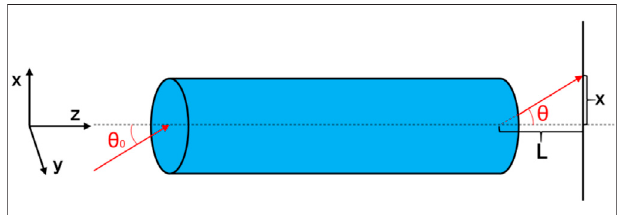
FIGURE 1 | Schematics of measuring FF power distributions.